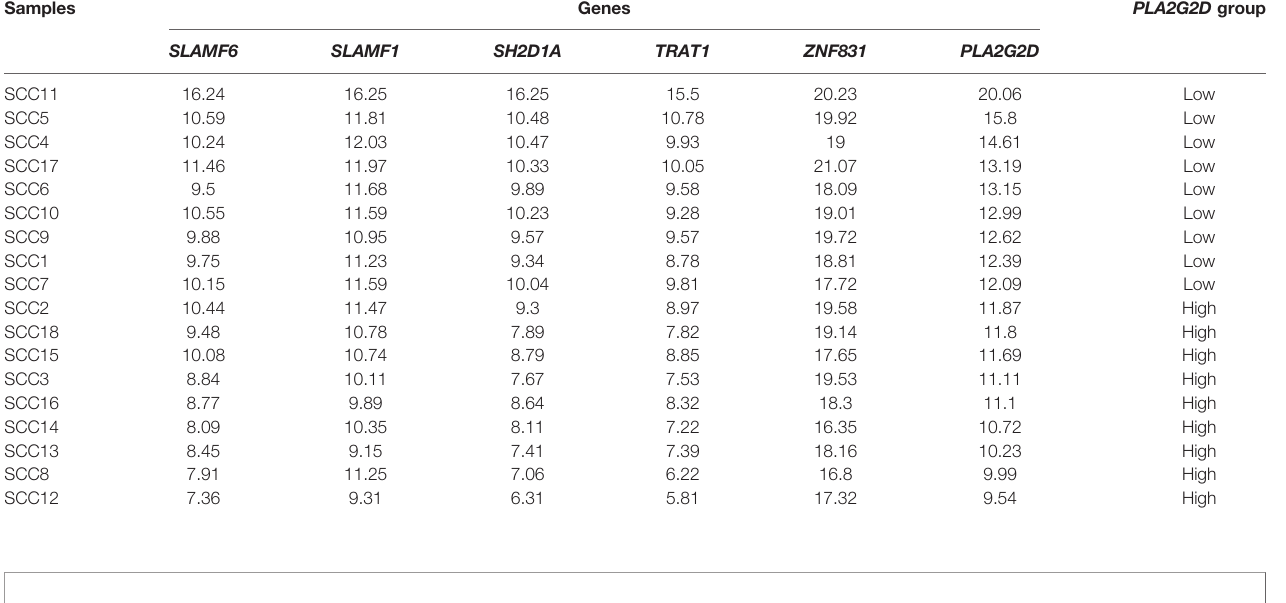
TABLE 4 | qRT-PCR D CT value of PLA2G2D and other fi ve co-expressed genes. Samples Genes PLA2G2D group